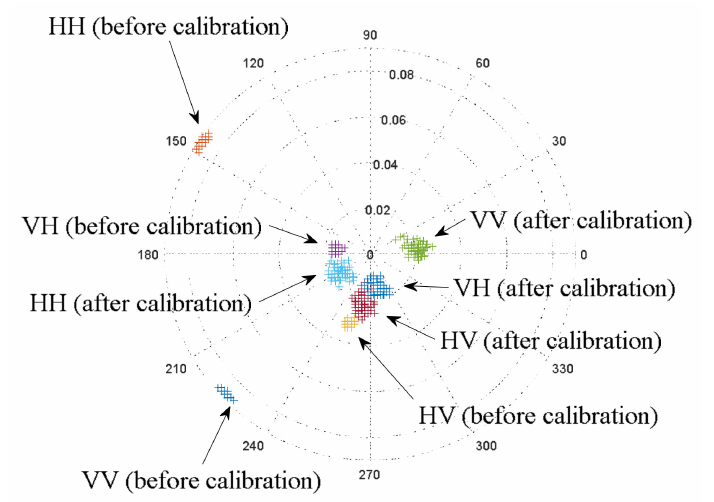
Figure 6. Target marks of the received signal (the second letter in the designation) relative to the transmitted signal unit (the first letter in the designation) in polar coordinates before and after calibration (linear polarization, car, profile angle 0 ◦ , number of marks for each observation—64). After calibration, HV and VH are almost identical in the polar chart. The identical HV and VH responses confirm the reciprocal scattering [11]. Consequently, the calibration was performed correctly and the results make sense according to the physics. The experiment also showed that the obtained phase difference | ϕ VV − ϕ HH | = 8 0 corresponds to the results stated in [1] (p. 59), where the mean square error is σ = 6.8 0 . Below is the